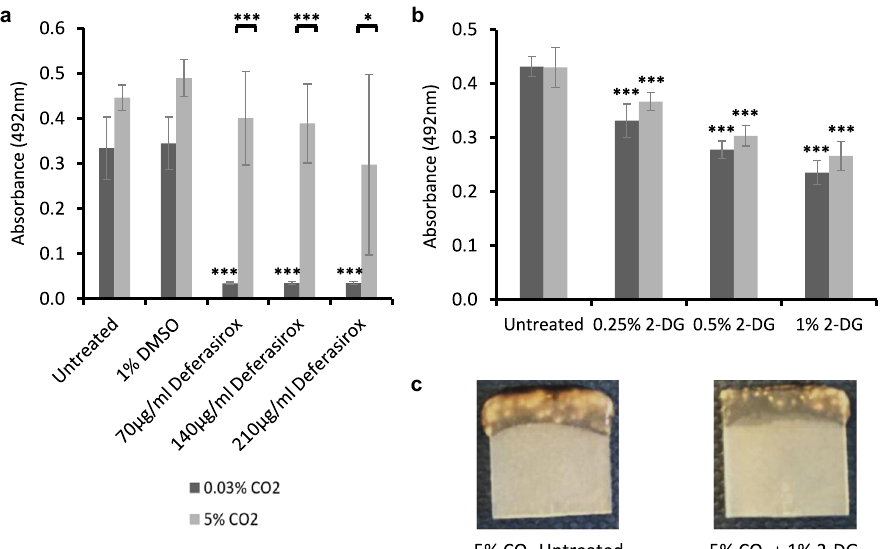
Fig. 9 Ef fi cacy of potential treatments to combat C . albicans bio fi lms grown in high (5%) CO 2 . Bio fi lms were seeded and grown for 48 h before XTT quanti fi cation. a Bio fi lm growth assay of SN250 in the presence of the Fe 3 + chelator Deferasirox. Graph represents two biological replicates each containing technical triplicates, error bars denote standard deviation. b Bio fi lm growth assay of SN250 in the presence of the glycolytic inhibitor 2-DG. Graph represents three biological replicates each containing technical triplicates, error bars denote standard deviation. Two-way ANOVAs followed by Tukey tests for multiple comparisons were carried out: * p < 0.05, *** p < 0.001. Asterisks directly above the bars indicate a signi fi cant difference to the untreated SN250 in the same CO 2 environment. c Representative images of SN250 bio fi lms grown in 5% CO 2 ± 2-DG for 48